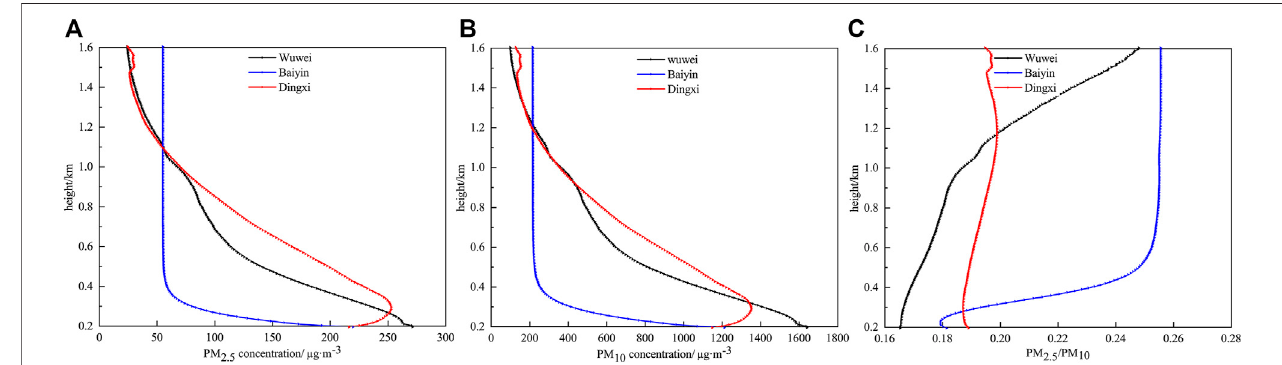
FIGURE 6 | Vertical variation of PM 2.5 and PM 10 average concentrations over the strong dust period (A) PM 2.5 ; (B) PM 10 ; and (C) PM 2.5 /PM 10